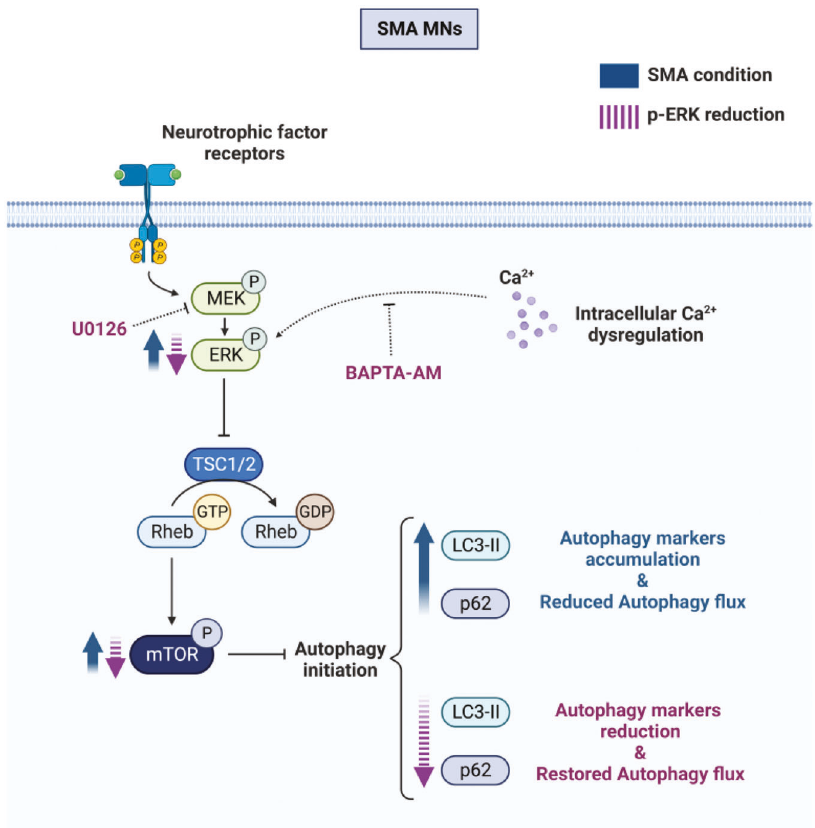
Fig. 7 Proposed mechanisms involved in ERK and autophagy pathways regulation in SMN-reduced MNs. In SMA condition, ERK and mTOR phosphorylation had increased in MNs, together with an increase of the autophagy markers LC3-II and p62, suggesting a reduction of the autophagic fl ux. ERK MAPK pharmacological inhibition or reduction of intracellular calcium levels prevented ERK phosphorylation, reduced mTOR phosphorylation, and restored autophagy markers to a level comparable to non-SMA MNs (created with